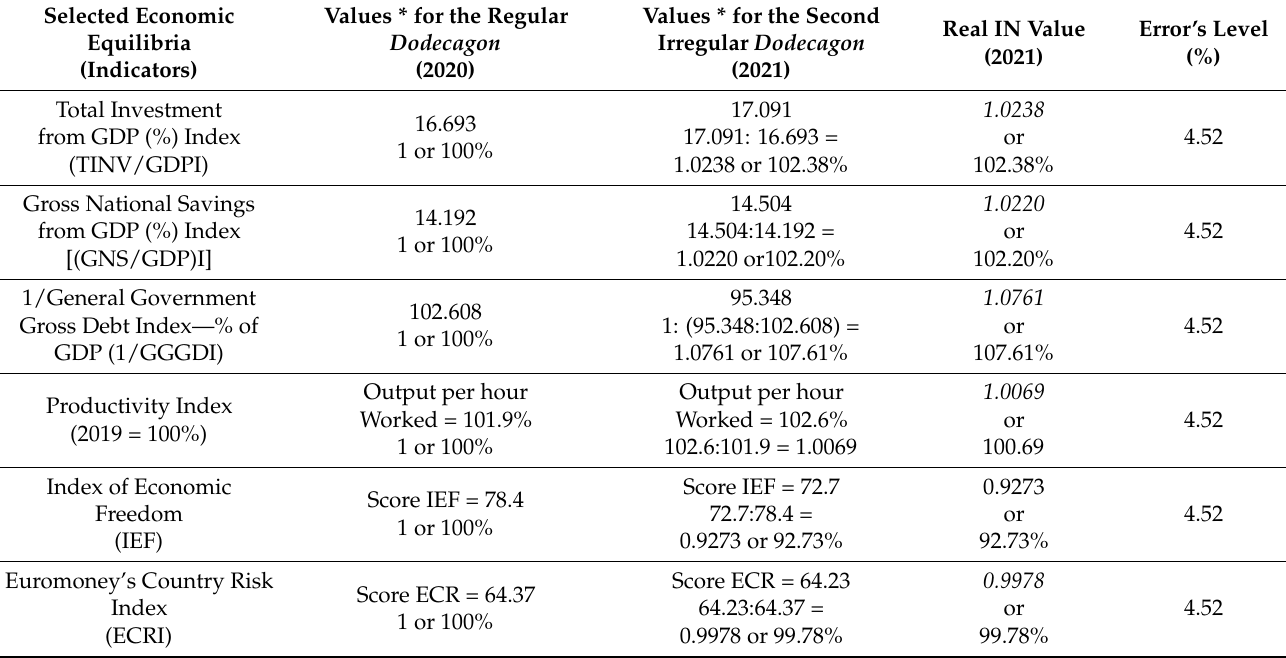
Table 6. The value of the next six essential indicators of MID, adequate in a “first” acceptable IN as dodecagon in terms of decision risk, based on UK data, for “ 12-go ”’